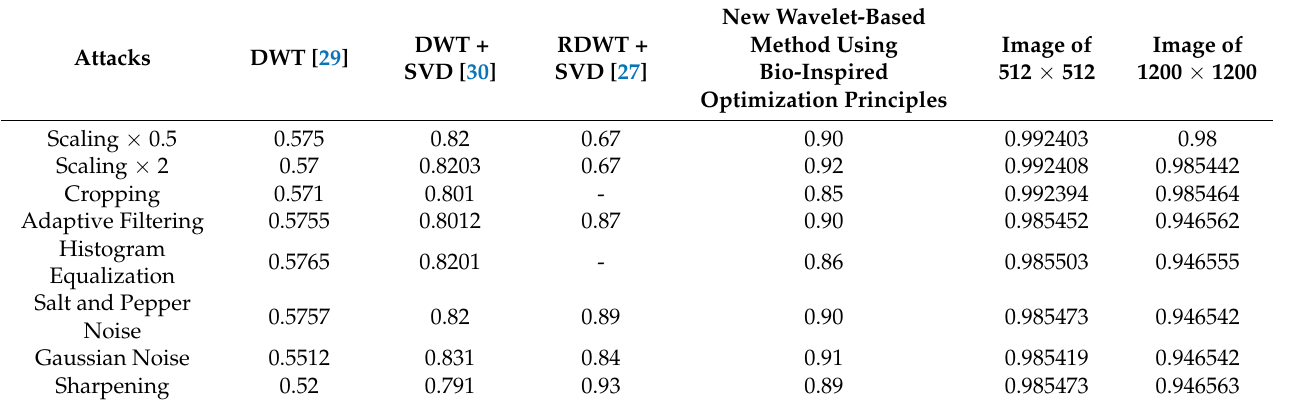
Table 8. Results comparison of NC for different types of attacks.